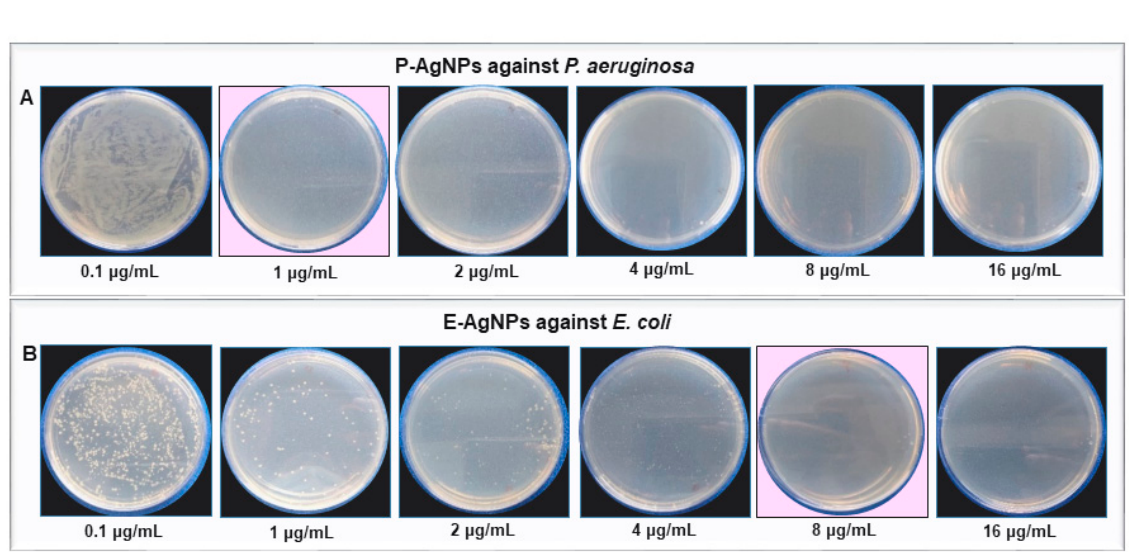
Figure 10. Cell viability test at different concentrations ranging from 0.1–16 μ g/mL of ( A ) P-AgNPs against P. aeruginosa and ( B ) E-AgNPs against E. coli . The pink background shows the MBC values of respective pathogens with complete growth inhibition.